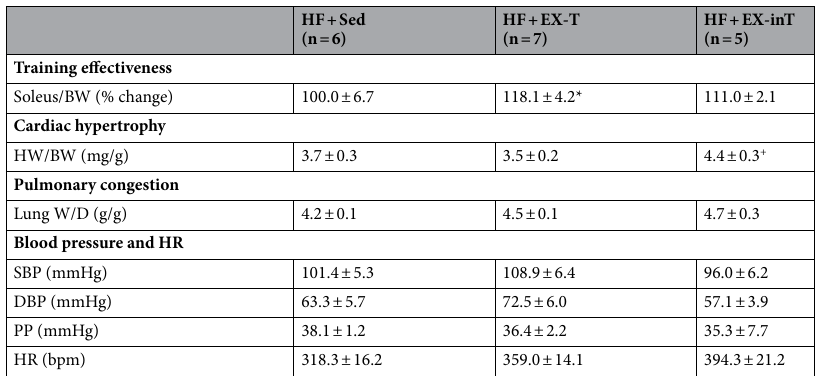
Table 1. Resting characteristics and cardiovascular parameters in HF after 6 weeks of exercise training (EX). Values are expressed as mean ± SEM. T: tolerant; inT: intolerant; HW: heart weight; HW/BW: heart weight/ body weight; lung W/D: Lung Wet/Dry; SBP: systolic blood pressure; DPB: diastolic blood pressure; PP: pulse pressure; HR: heart rate. One-way ANOVA, Sidak post hoc analysis. *vs. HF + Sed, + vs. HF + EX-T, p < 0.05.